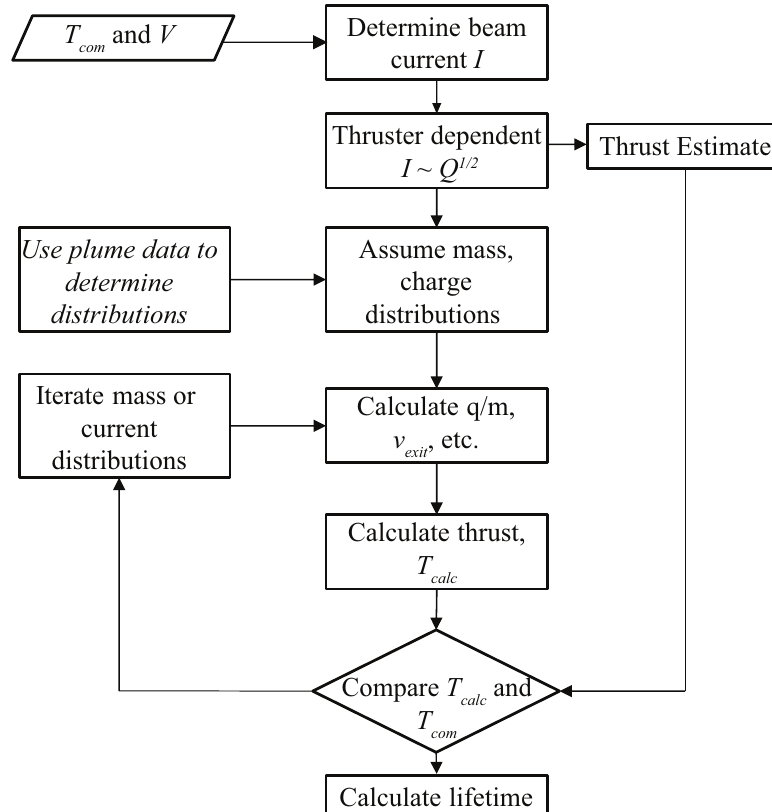
Figure 4. Description of grid impingement life model detailing required inputs and the iterative process employed to determine a lifetime